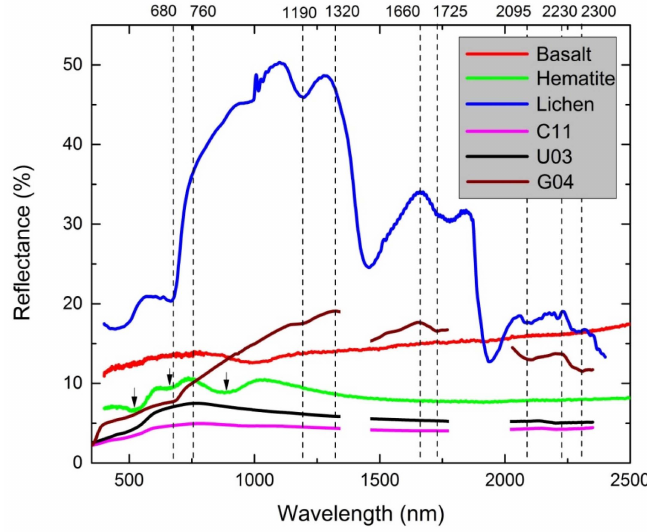
Figure 9. Comparison between field-derived spectra for Tenerife lavas with lab-measurement of samples for basalt, hematite and lichen. The basalt (igneous-mafic-fine-basal2) and hematite (oxide-none-coarse-o01a) spectra are obtained from the ASTER spectral library [63]. The lichen spectrum shows typical spectral features of Stereocaulon [33]. Spectral features for lichen and lavas, and for hematite, are indicated by dashed lines and arrows,